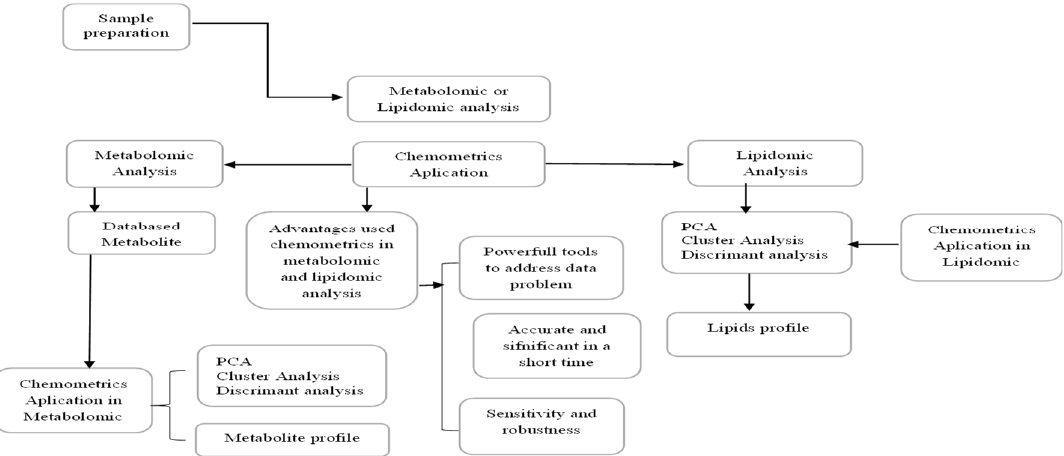
Figure 1. Chemometric applications in metabolomic and lipidomic